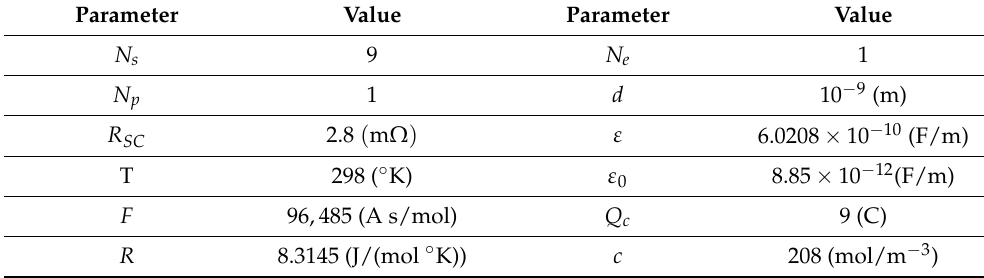
Table 3. Parameters of the SC model. Parameter